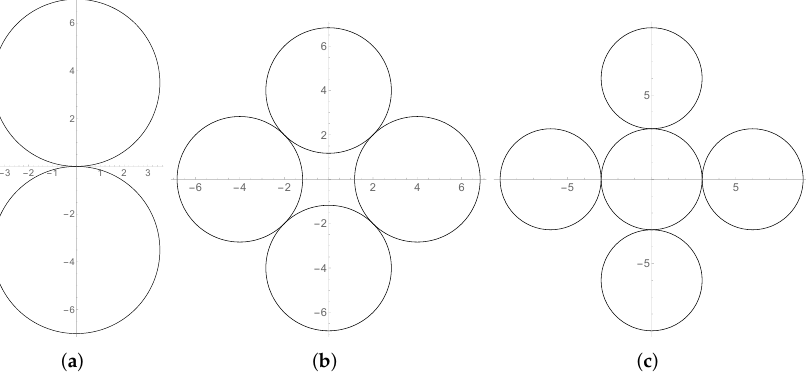
Figure 3. New orbit traps obtained with the Euclidean metric. ( a ) two orbit traps; ( b ) four orbit traps; and ( c ) five orbit